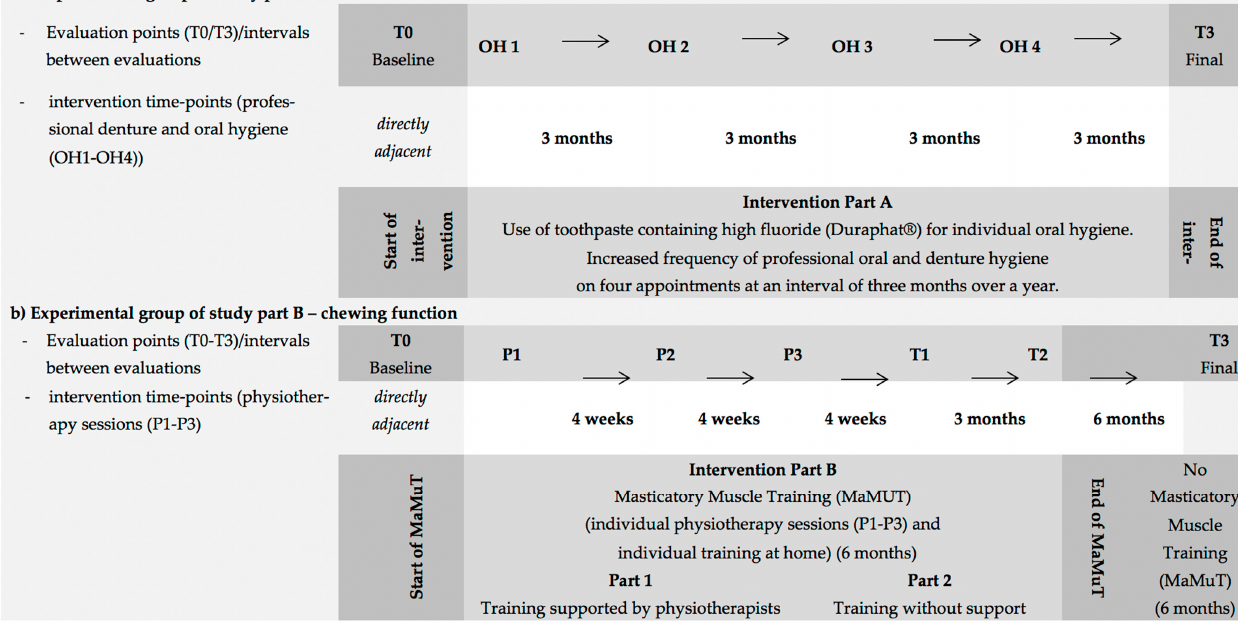
Figure 1. Timetable for evaluation points (T0/T3 for study part A—oral health, T0/T1/T2/T3 for study part B—chewing function) and intervention time-points (OH1–OH4 for study part A—oral health, P1–P3 for study part B—chewing function) for a) experimental group of study part A—oral health and b) experimental group of study part B—chewing function (OH—intervention part A, professional denture and oral hygiene; p —interven- tion part B—chewing function, physiotherapy sessions; MaMuT—masticatory muscle training).